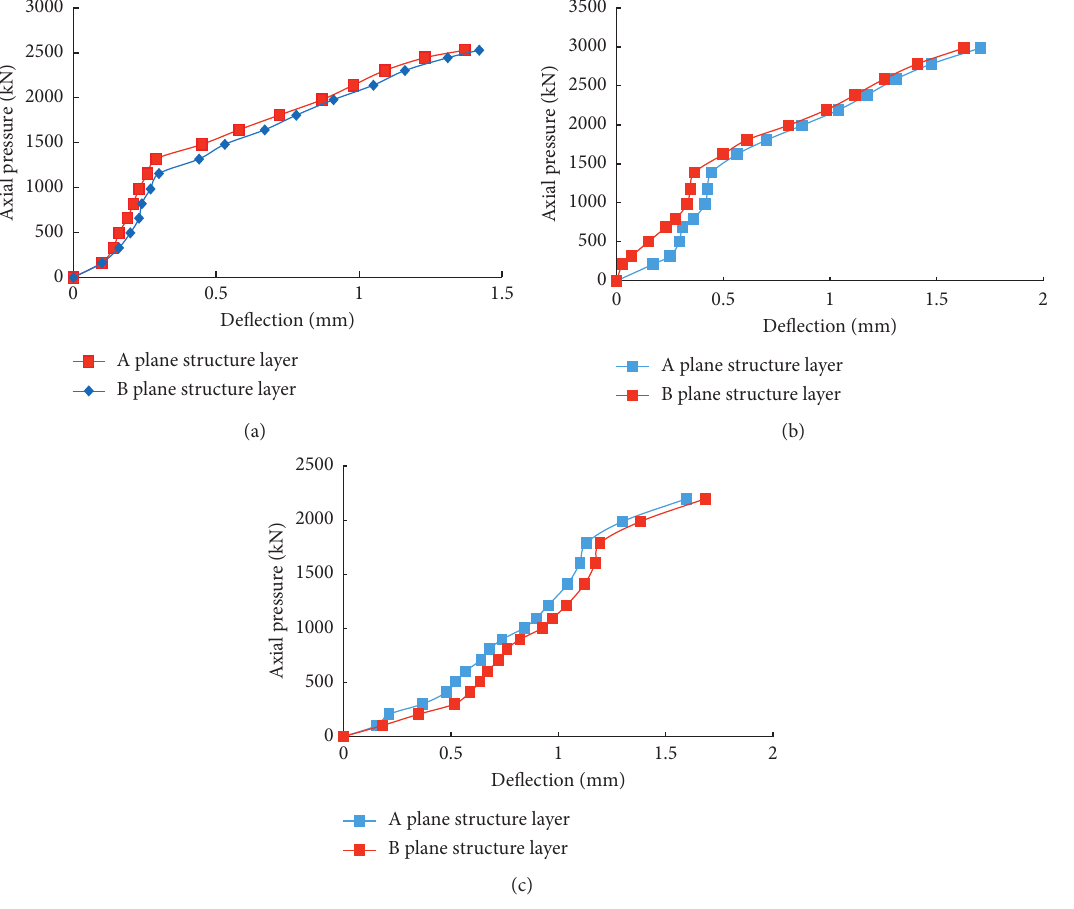
Figure 5: Load-deflection curve. (a) W3 specimen; (b) W4 specimen; (c) W5